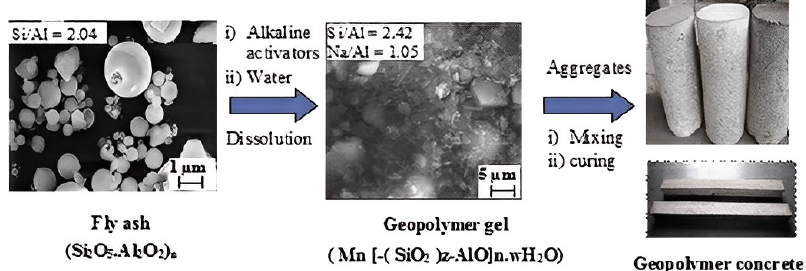
Figure 2. Stages of geopolymer formation [37]. (Reprinted with permission from the publisher Elsevier; License No. 5471710688327).